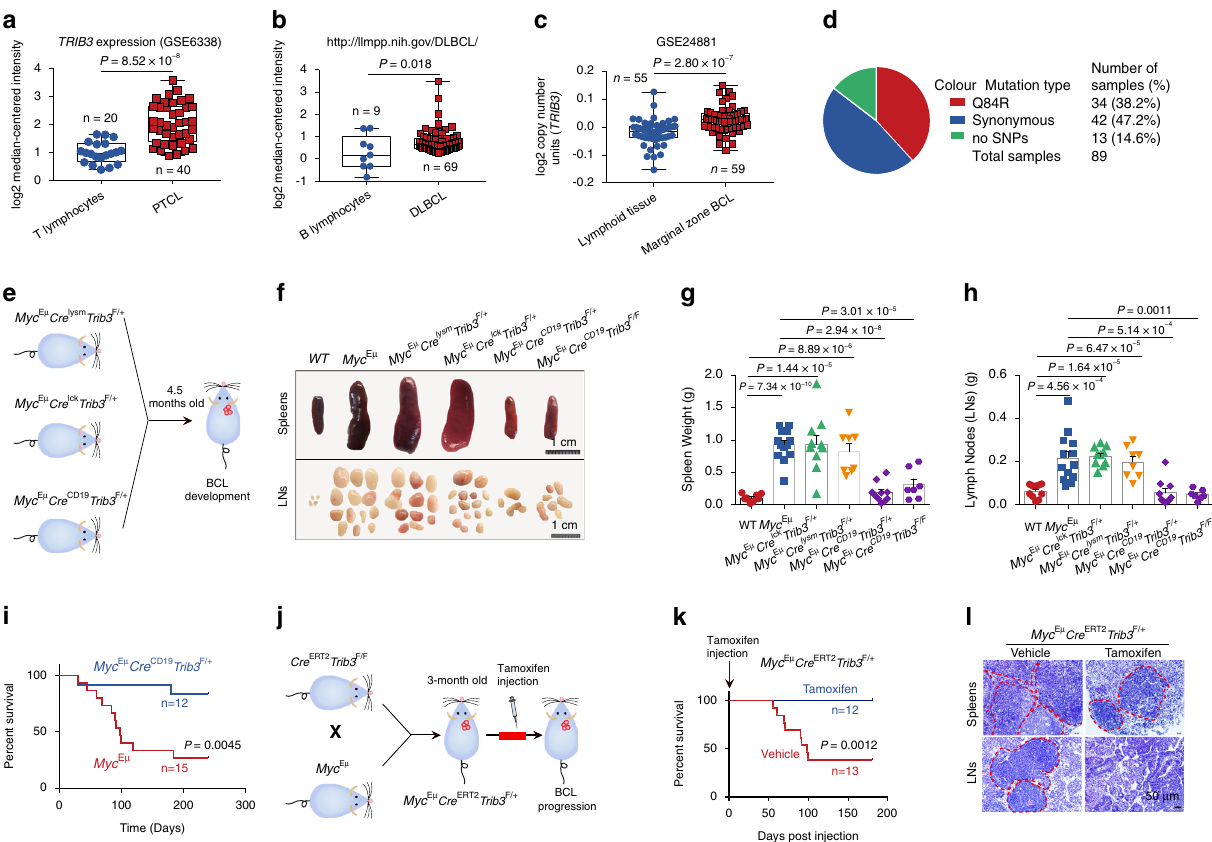
Fig. 1 TRIB3 promotes B cell lymphomagenesis. a , b The mRNA level of TRIB3 in lymphoma patients and the corresponding control groups. The center line indicates the median, bounds of box = 25th and 75th percentiles; bars = 10th and 90th percentiles; whiskers = min to max, show all points. Statistical signi fi cance was determined by two-tailed Student ’ s t test. P values: 8.52 × 10 − 8 a ; 0.018 b . c TRIB3 gene copy numbers in the lymphoma set (GSE24881) were analyzed at the Oncomine website. The center line indicates the median, bounds of box = 25th and 75th percentiles; bars = 10th and 90th percentiles; whiskers = min to max, show all points. Statistical signi fi cance was determined by two-tailed Student ’ s t test. P value: 2.80 × 10 − 7 . d Pie chart showing all the types and statistics of TRIB3 gene mutation in 89 lymphoma patients. e Schematic strategy for studying the development of B cell lymphoma (BCL) in Myc E μ mice with myeloid cell-speci fi c deletion of Trib3 ( Myc E μ Cre Lysm Trib3 F/ + ), thymocyte-speci fi c deletion of Trib3 ( Myc E μ Cre L ck Trib3 F/ + ), or B lymphocyte-speci fi c deletion of Trib3 ( Myc E μ Cre CD19 Trib3 F/ + ). f Representative spleens and lymph nodes (LNs) obtained from WT, Myc E μ , Myc E μ Cre Lysm Trib3 F/ + , Myc E μ Cre Lck Trib3 F/ + , Myc E μ Cre CD19 Trib3 F/ + , or Myc E μ Cre CD19 Trib3 F/F mice (4.5 months old). Scale bar, 1 cm. g , h The data indicate the spleen and LN weights of WT ( n = 10), Myc E μ ( n = 13), Myc E μ Cre Lysm Trib3 F/ + ( n = 8), Myc E μ Cre L ck Trib3 F/ + ( n = 10), Myc E μ Cre CD19 Trib3 F/ + ( n = 10), or Myc E μ Cre CD19 Trib3 F/F mice ( n = 7) (4.5 months old). Data are represented as means ± SEM. Statistical signi fi cance was determined by two- tailed Student ’ s t test. P values: 7.34 × 10 − 10 (WT vs. Myc E μ ), 1.44 × 10 − 5 (WT vs. Myc E μ Cre L ck Trib3 F/ + ), 8.89 × 10 − 6 (WT vs. Myc E μ Cre Lysm Trib3 F/ + ), 2.94 × 10 − 8 ( Myc E μ vs. Myc E μ Cre CD19 Trib3 F/ + ), 3.01 × 10 − 5 ( Myc E μ vs. Myc E μ Cre CD19 Trib3 F/F ) g ; 4.56×10 − 4 (WT vs. Myc E μ ), 1.64 × 10 − 5 (WT vs. Myc E μ Cre L ck Trib3 F/ + ), 6.47 × 10 − 5 (WT vs. Myc E μ Cre Lysm Trib3 F/ + ), 5.14× 10 − 4 ( Myc E μ vs. Myc E μ Cre CD19 Trib3 F/ + ), and 0.0011 ( Myc E μ vs. Myc E μ Cre CD19 Trib3 F/F ) h . i Kaplan – Meier survival curves for Myc E μ ( n = 15) and Myc E μ Cre CD19 Trib3 F/ + mice ( n = 12). Statistical difference was determined by two-sided log-rank test. P value: 0.0045. j Schematic representation of generating the inducible deletion of Trib3 in Myc E μ mice ( Myc E μ Cre ERT2 Trib3 F/ + ). k Kaplan – Meier survival curves for Myc E μ Cre ERT2 Trib3 F/ + mice treated with vehicle ( n = 13) or tamoxifen ( n = 12 per group, 250mg/kg). Statistical difference was determined by two-sided log-rank test. P value: 0.0012. l Representative H&E staining of the spleens and LNs of 5-month-old Myc E μ Cre ERT2 Trib3 F/ + mice treated with or without tamoxifen. Scale bar, 50 μ m. The data are presented as presentative from three independent experiments. The Myc E μ Cre Lysm Trib3 F/ + , Myc E μ Cre L ck Trib3 F/ + , Myc E μ Cre CD19 Trib3 F/ + , Myc E μ Cre CD19 Trib3 F/F , and Myc E μ Cre ERT2 mice are heterozygous for the Myc E μ allele. Source data are provided as a Source Data fi